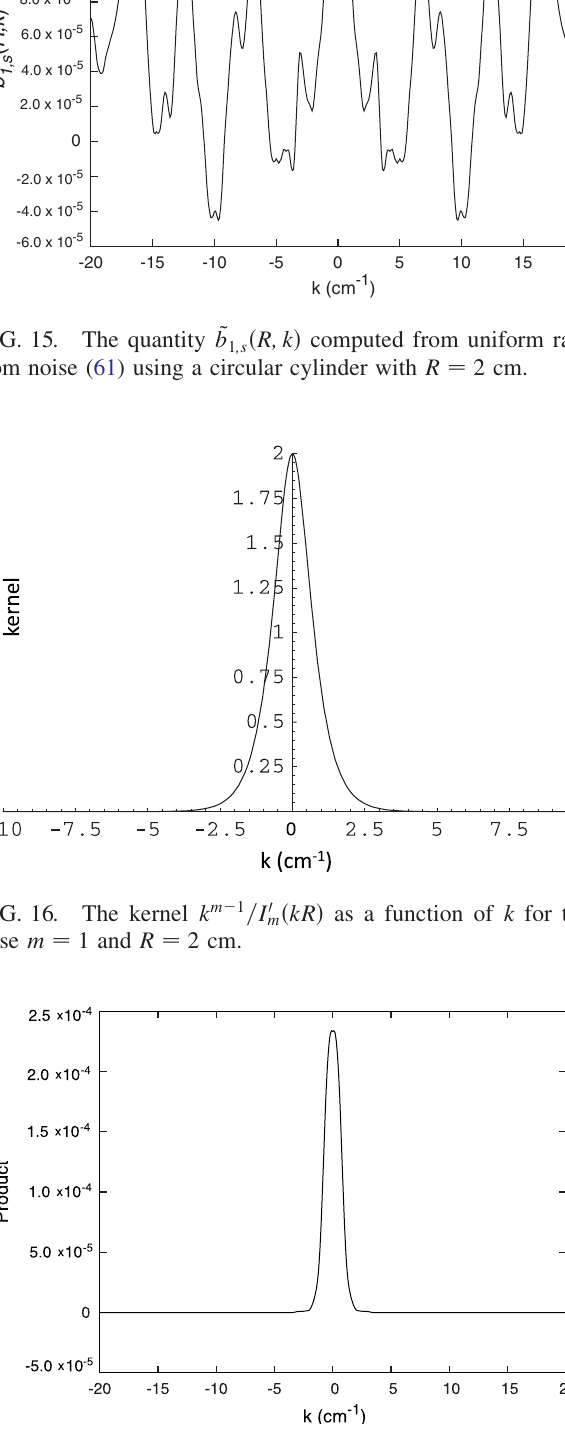
FIG. 17. The product k m (cid:1) 1 computed from uniform random noise (61) with m ¼ 1 and R ¼ 2 cm .